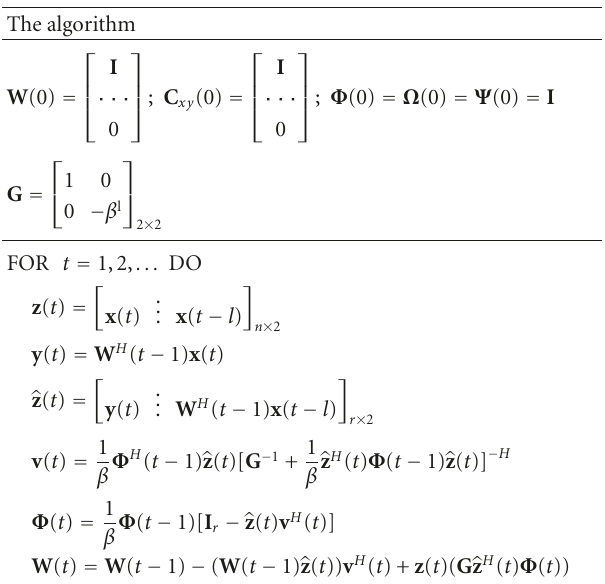
Table 4: Truncated window fast CPAST